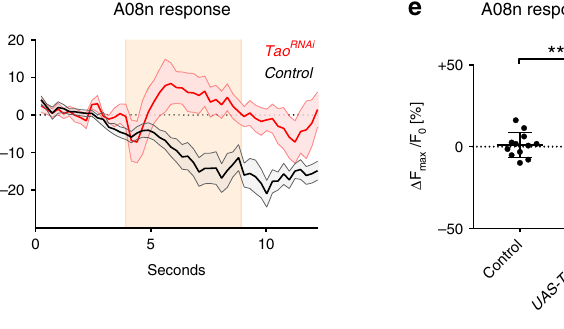
Fig. 6B – D). These data show that loss of Tao in A08n neurons gives rise to functional ectopic connectivity with C3da sensory neurons while partially impairing C4da – A08n neuron physiolo- gical